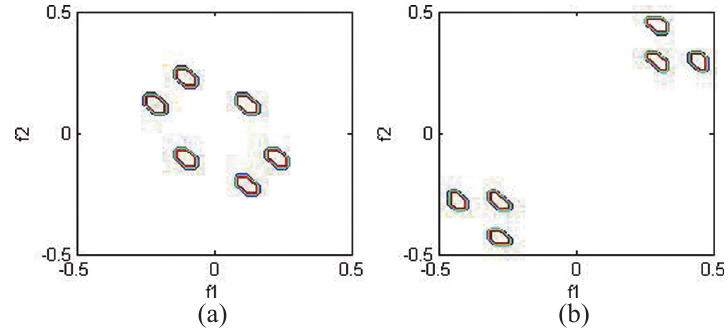
Fig. 6. Kernel images of object template (a) Inner fault kernel image (b) Ball fault kernel